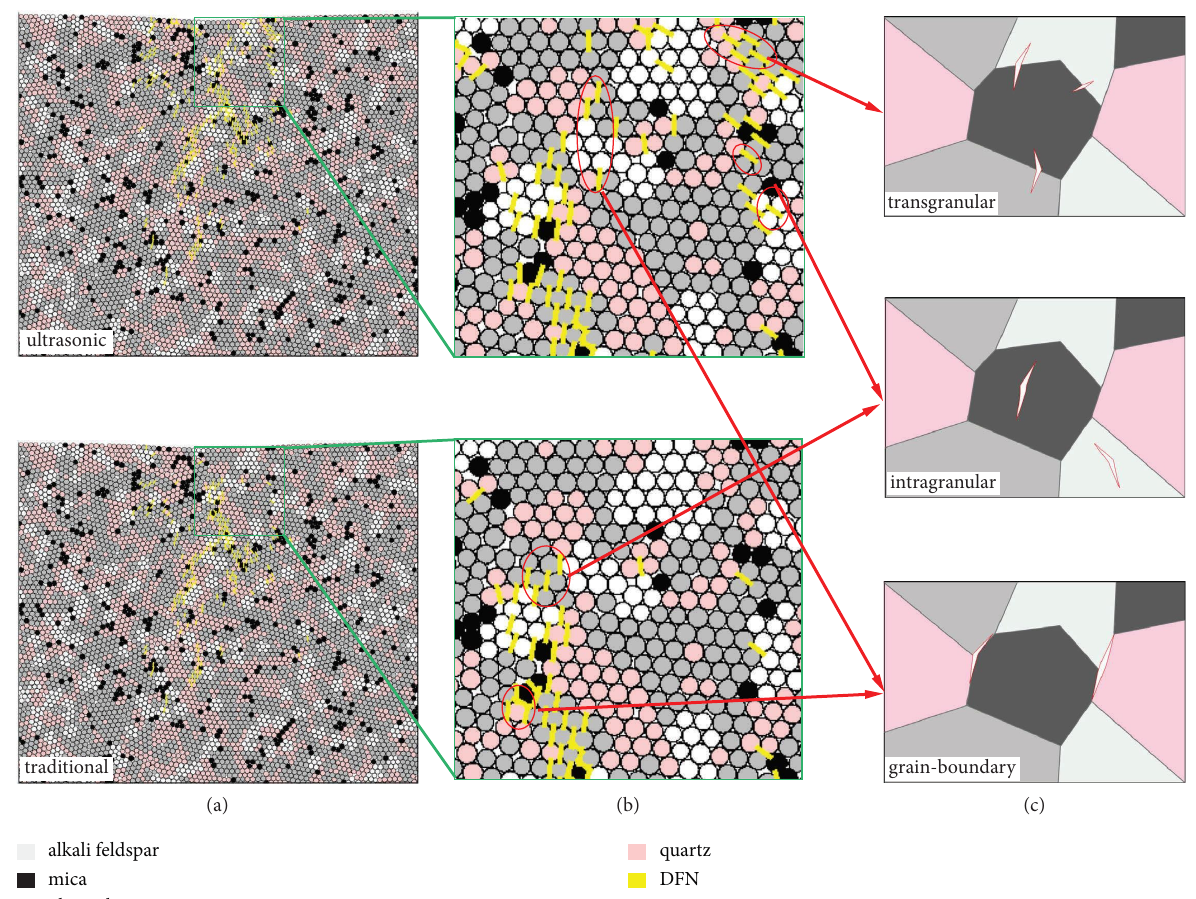
Figure 13: Crack types in granite after loading: (a) cracks in granite under ultrasonic vibration-assisted loading and single rolling loading (b) local magnifcation of mineral crystal cracks, and (c) types of mineral crystal cracks.